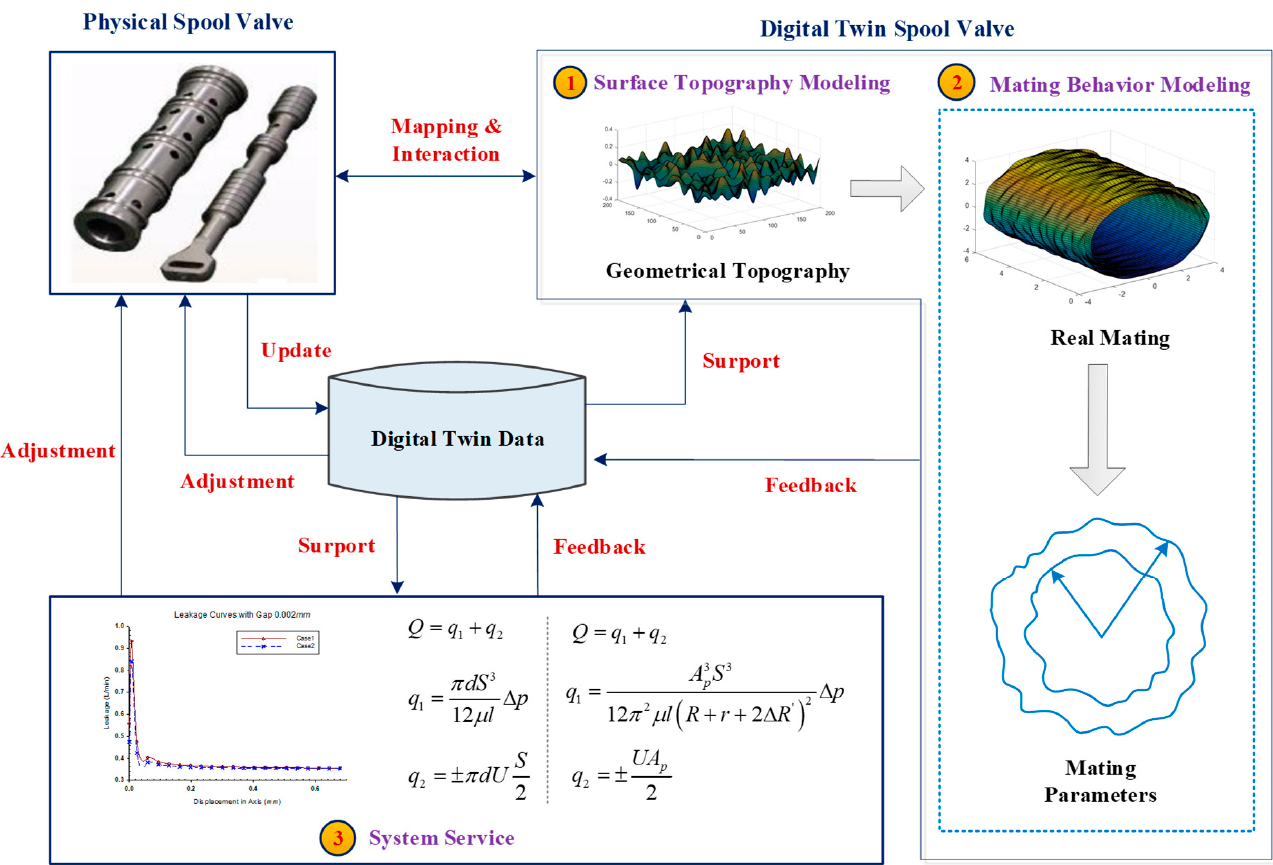
Figure 1. Overall framework of this paper. (1) With design tolerance as the basis, this paper constructed an assembly interface of precision spool valves that could characterize actual errors. The microscopic topography of the cylindrical assembly interface between the valve spool and the valve sleeve is the key factor affecting the assembly clearance and oil leakage of the precision spool valve. However, the theoretical CAD model, the only model available in the design stage, is unable to reflect the complex geometrical topography of the interface. Although size and form tolerances will be assigned to the assembly interface and related geometrical features in the design stage, these tolerances only reflect the allowable error range, namely the tolerance zone, of the assembly interface after machining rather than manifest the specific topography features. Therefore, it is of necessity to combine the CAD model and design tolerance information to establish a geometrical model of the assembly interface topography that can reveal the actual error, so as to lay the foundation for establishing the digital twin spool